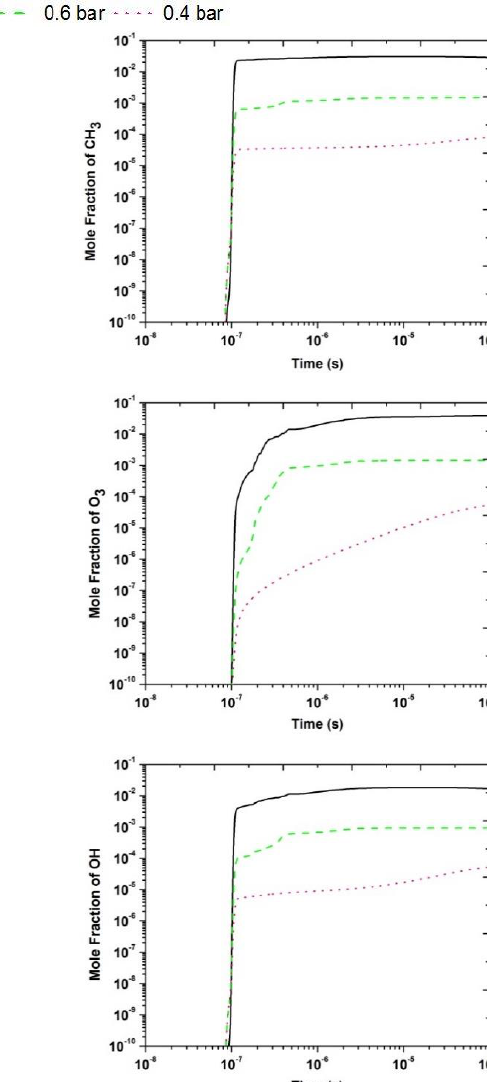
Table 3. Electrical output of plasma actuated test cases.